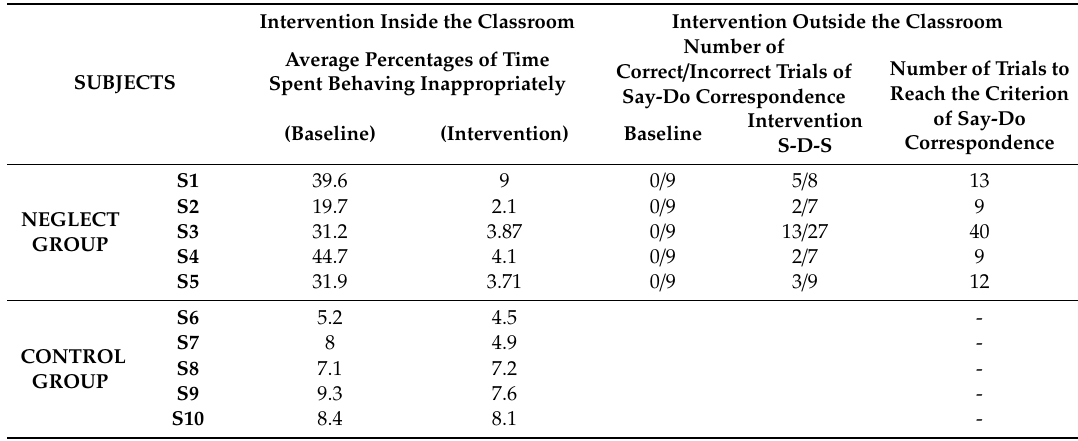
Figure 1. Graphic representation of the average percentage of time per session spent behaving inappropriately (standing up, absent from tasks, disruptive behaviors) during school activities, by the neglected group and the control group respectively. The x axis represents the sessions. Between sessions 10 and 11 took place the intervention outside the classroom carried out by the authors with the five neglected children. Table 2. Results specified by child.